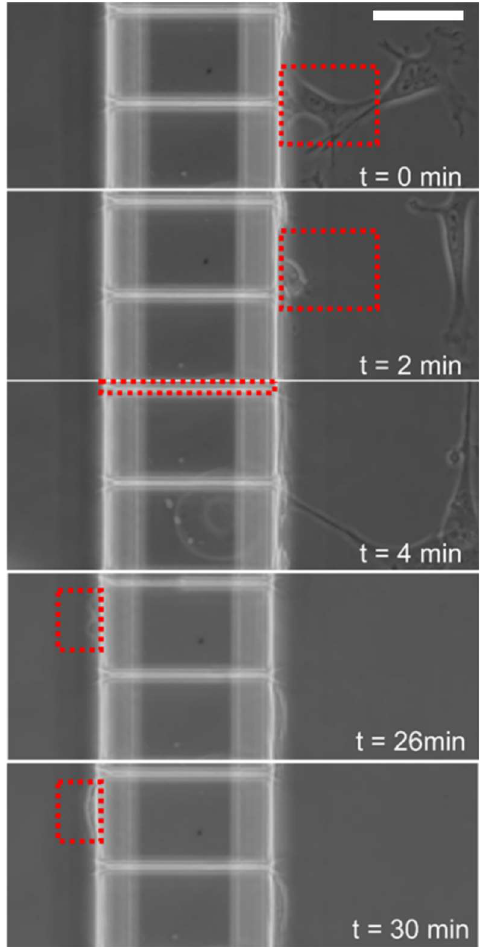
Figure 2. Time lapse microscopy revealed spontaneous migration of primary myoblast cells across PDMS based microfluidic channels. Phase contrast images of a representative cell at different time intervals traversing a microchannel of 5 µm width and 100 µm length. Red boxes indicate tracking of representative cell from the proximal (right) to distal chamber (left). Horizontal scale bar represents 50 µm.